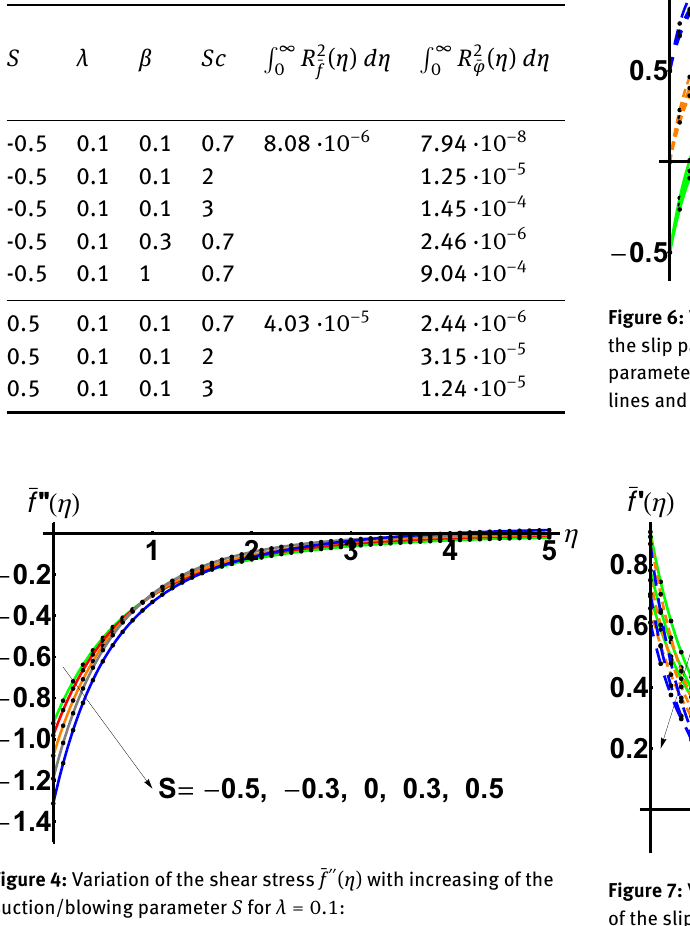
Table 10: Integral of the square residual given by Eqs (44) and (45) respectively, for different values of the parameters S , λ , β and Sc